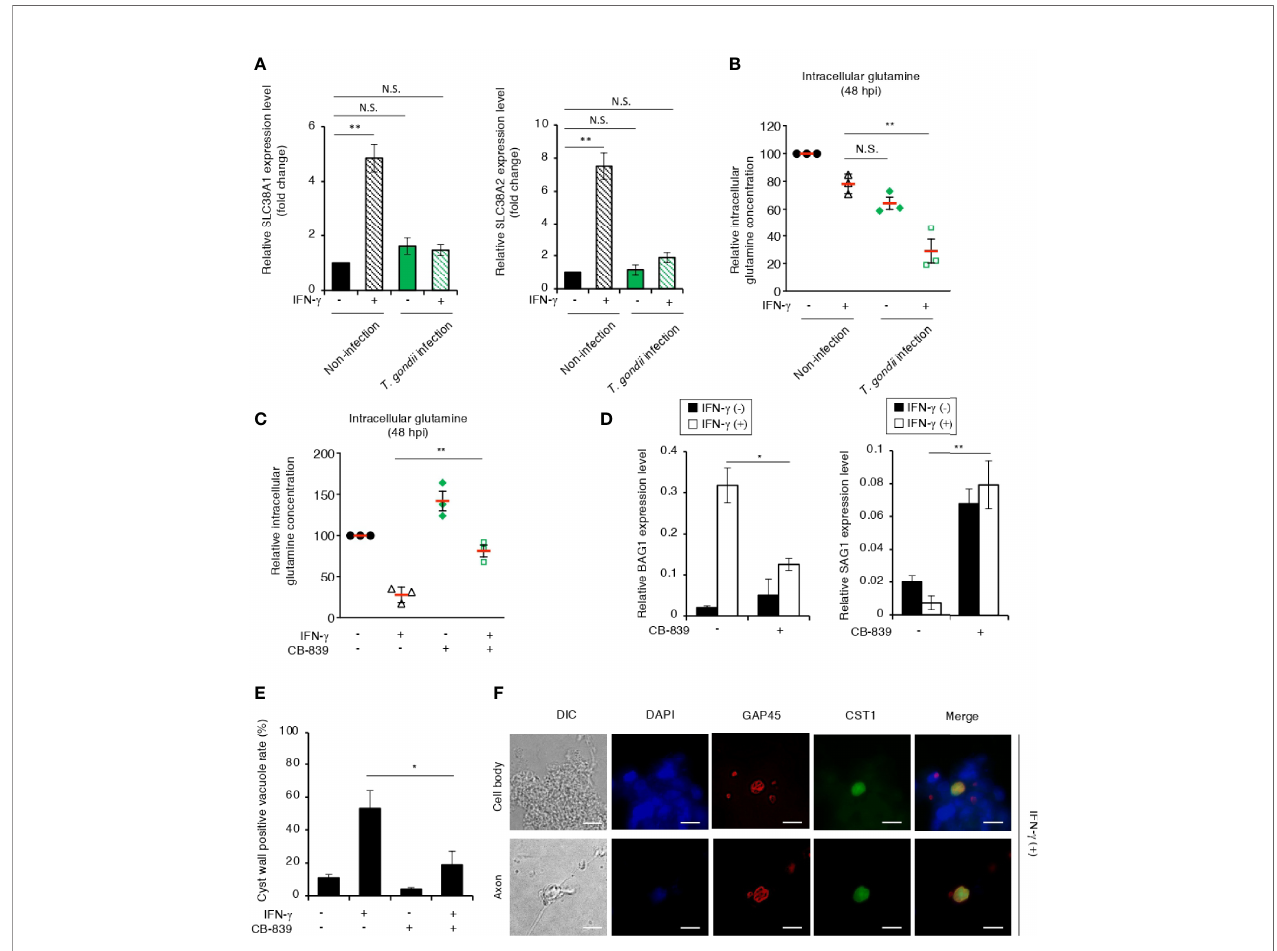
FIGURE 6 | T. gondii stage conversion is accelerated by IFN- g -dependent glutamine starvation in human iPSC-derived glutamatergic neurons. (A) Human iPSC- derived glutamatergic neurons uninfected or infected with T. gondii ME49 were untreated or treated with IFN- g and incubated for 24 h. The SLC38A1 or SLC38A2 mRNA level was analyzed by use of quantitative RT-PCR. (B) Human iPSC-derived glutamatergic neurons uninfected or infected with T. gondii ME49 were untreated or treated with IFN- g . The level of intracellular glutamine at 48 h after parasite infection was measured by ELISA. (C) Human iPSC-derived glutamatergic neurons infected with T. gondii ME49 were untreated or treated with IFN- g and/or CB-839. The level of intracellular glutamine at 48 h after parasite infection was measured by ELISA. (D) Human iPSC-derived glutamatergic neurons infected with T. gondii ME49 were untreated or treated with IFN- g and/or CB-839. The BAG1 or SAG1 mRNA level at 48 h after parasite infection was analyzed by use of quantitative RT-PCR. (E, F) Human iPSC-derived glutamatergic neurons infected with T. gondii ME49 were treated with IFN- g . Cyst wall formation in the cell bodies or axons was assessed by IFA at 72 h post-infection. (E) The percentage of CST1-positive vacuoles was determined. (F) Representative IFA images of T. gondii GAP45 (red) and CST1 (green); the nuclei were stained with DAPI (blue). Scale bars correspond to 10 m m. Data are representative of three independent experiments. Values are means ± SD (three biological replicates per group from three independent experiments) (A – E) . * p < 0.05, ** p < 0.01, N.S., not signi fi cant; Student ’ s t